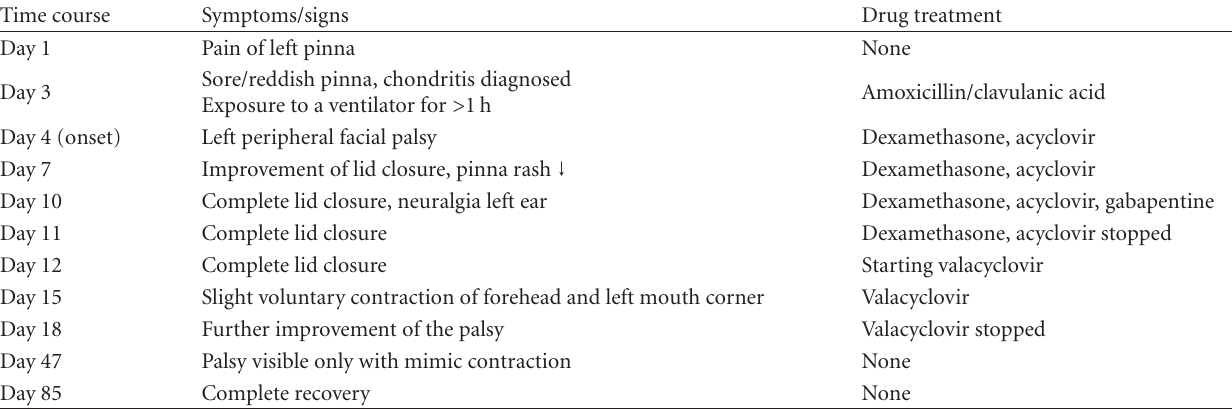
Table 1: Time course of the development and resolution of symptoms and signs and duration of